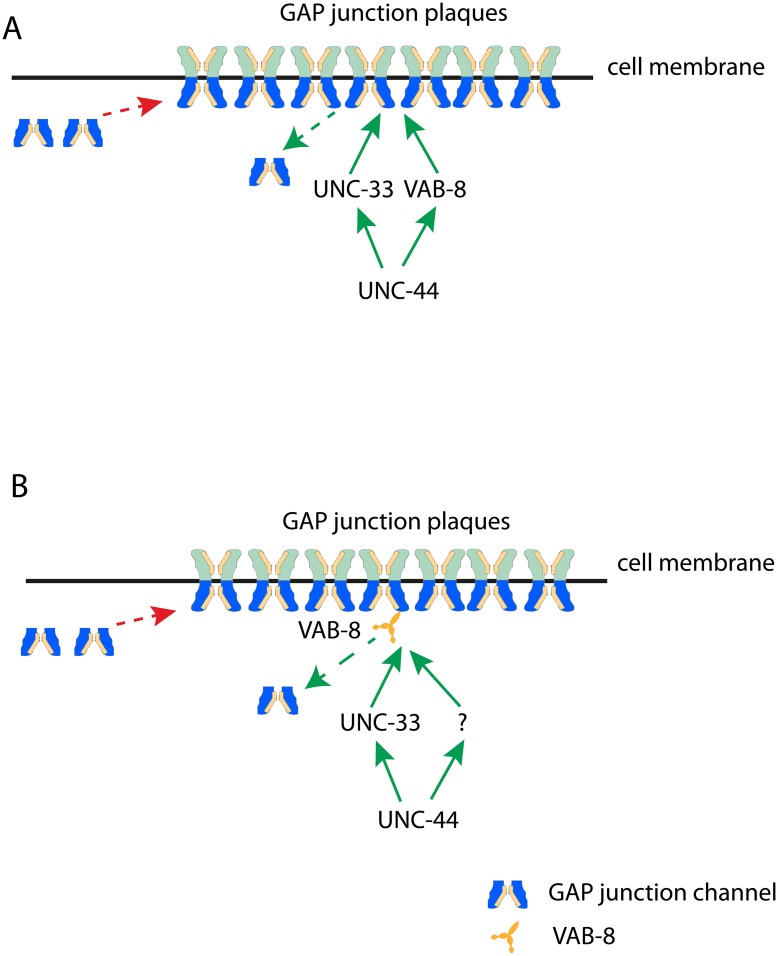
Models for the regulation of gap junctions the UNC-44/UNC-33/VAB-8 pathway.(A) VAB-8 and UNC-33 function in parallel at the downstream of UNC-44 in gap junction regulation. (B) In gap junction dynamics, UNC-33 works together with an unknown factor at the downstream of UNC-44 to regulate motor protein VAB-8 to control gap junction turnover.